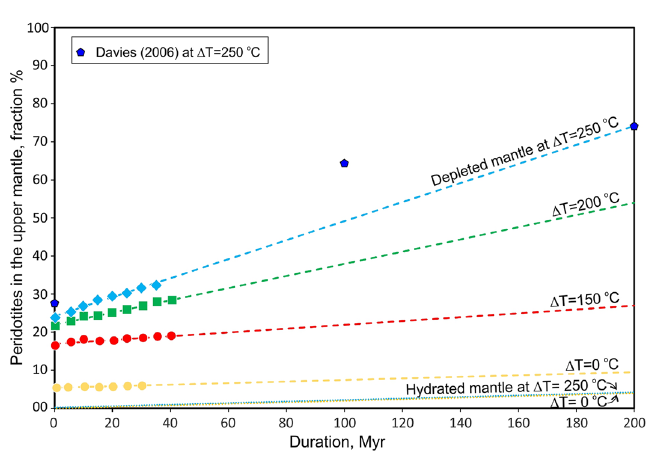
Figure 5. Shrinking of the V-shaped terrain and formation of sodic granitoids after stop pushing the plate at 20 myrs and elevated mantle temperature ΔT = 250 °C (T p = 1550 °C). ( a ) V-shaped terrain reaches ~ 200 km depth. Gravitational separation of the slab-related depleted mantle and eclogites in the transition zone (at 43.5 myrs from the beginning of the experiment). ( b ) Shrinking of V-shape terrain down to ~ 100 km depth. Formation of sodic granites derived from the metabasic rocks. Stretching of the hydrated peridotites with rare eclogites in the transition zone and in upper mantle (at 119.3 myrs from the beginning of the experiment). The insets show effective viscosity fields and stiffening of the V-shape terrain in time.